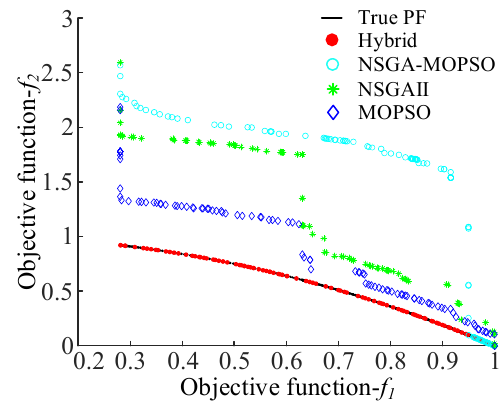
Figure 7. Comparison results for ZDT6. To quantitatively evaluate the performances of an algorithm, its convergence metric γ and diversity metric ∆ are calculated and given in Tables 3 and 4. In the tables, E( · ) denotes the mean value and σ ( · ) stands for the variance. Smaller values of both mean and variance indicate a better